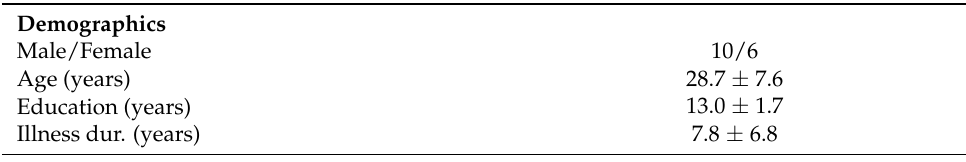
Table 10. Demographics information at the time of recruitment, illness information, and amount of recorded and analyzed data utterances.